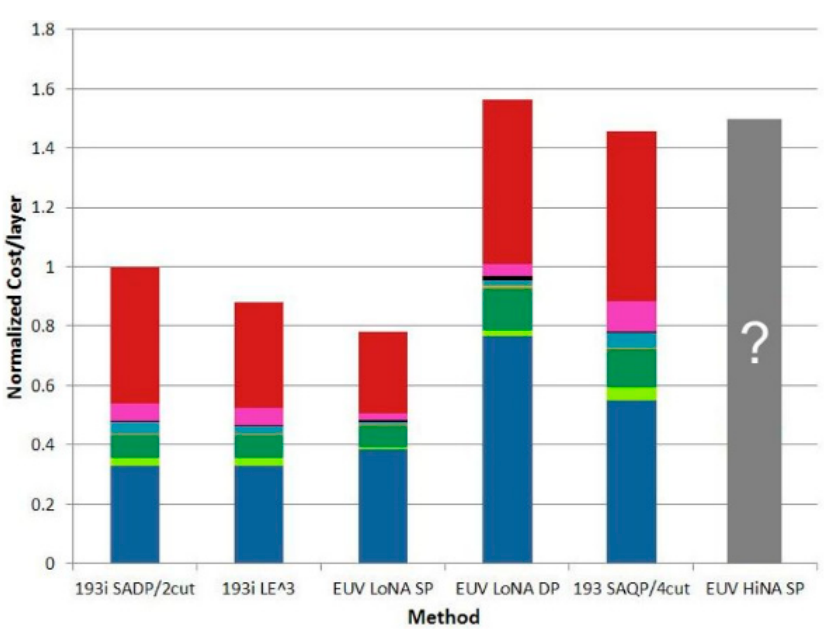
/ layer vs. lithography Figure 3. Normalized cost/layer vs . lithography method. Figure 3. Normalized cost